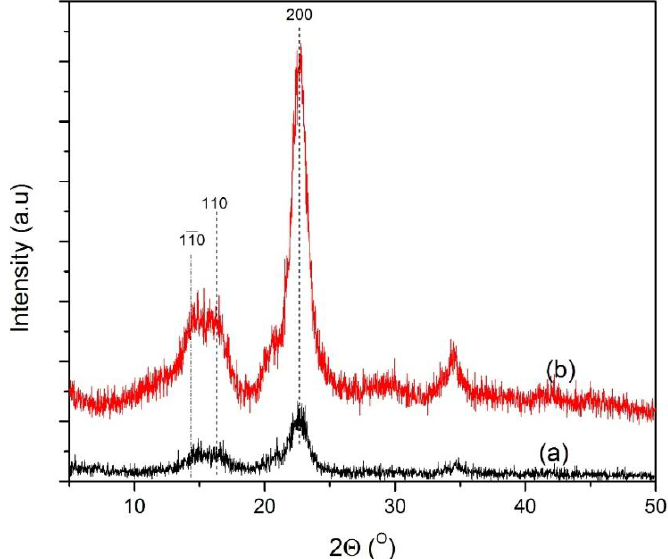
Figure 5. Microcrystalline cellulose: ( a ) untreated MCC; and ( b ) acid hydrolyzed in the presence of FeCl 3 catalyst. The percentage of crystallinity of the untreated MCC was determined as 56.05%, and this value increased to 83.46% after treatment with FeCl 3